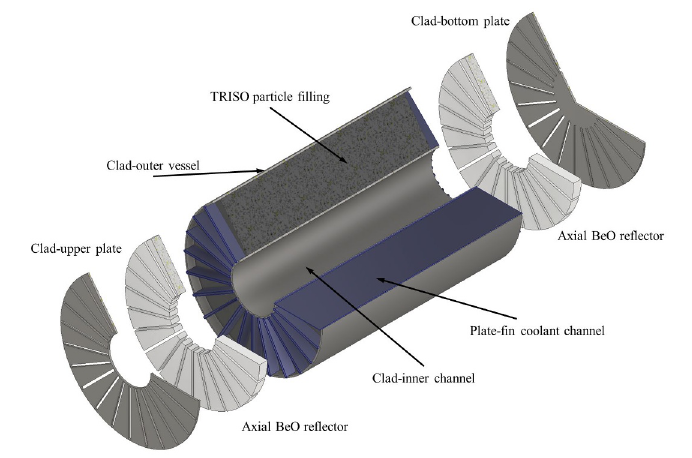
Figure 1. The design of integrated plate-fin fuel